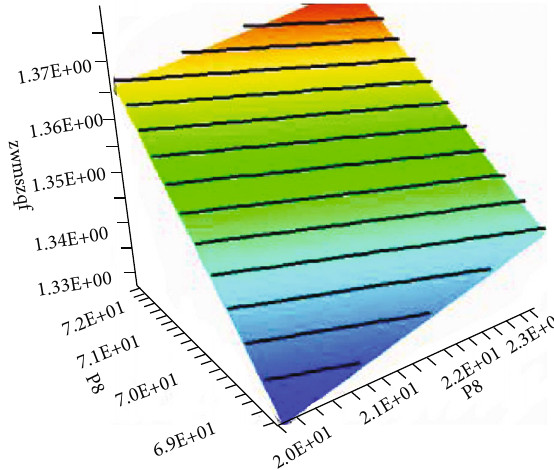
Figure 6: BCS safety factor response surface.